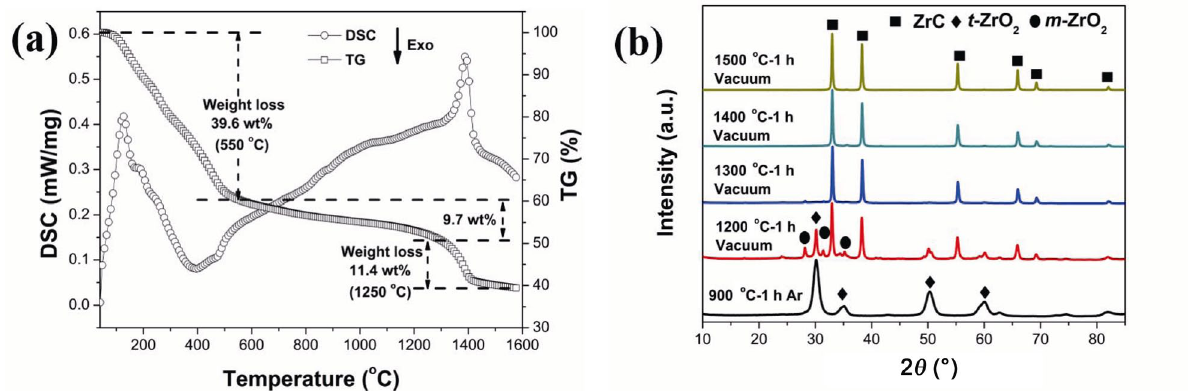
Fig. 3 (a) Typical TG–DSC curves of the dried gel in argon flow [21]. Reproduced with permission from Ref. [21], © Elsevier Ltd. 2018. (b) XRD patterns of the products obtained from pyrolyzing the dried gels at various temperatures [21]. Reproduced with permission from Ref. [21], © Elsevier Ltd. 2018.